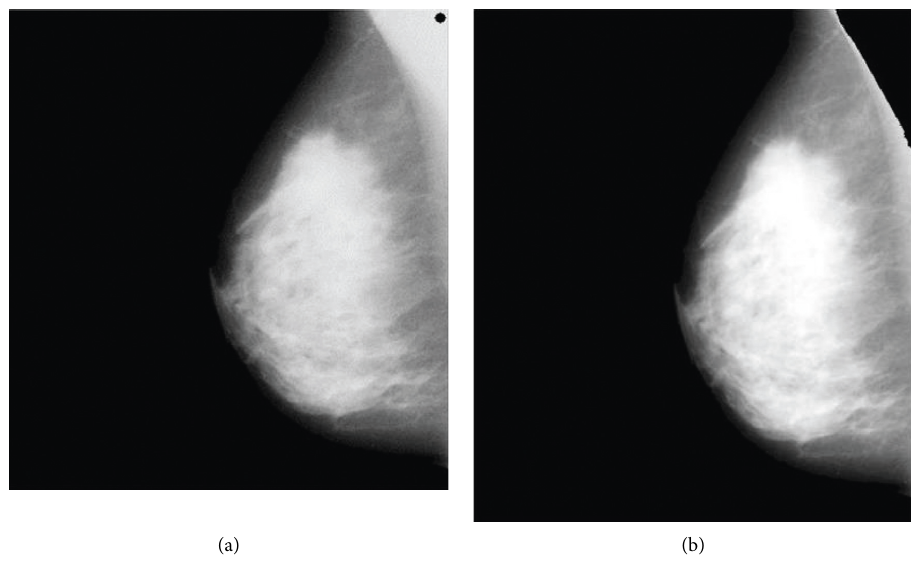
Figure 8: Image segmentation result. (a) The preprocessed image after enhancement with identified seed point. (b) Image after seg- mentation (pectoral muscle extraction).